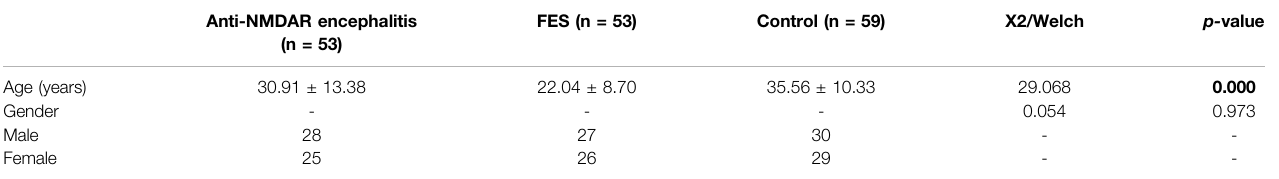
TABLE 1 | Characteristics of participants with anti-NMDAR encephalitis, fi rst-episode schizophrenia, and healthy individuals. Anti-NMDAR encephalitis (n =